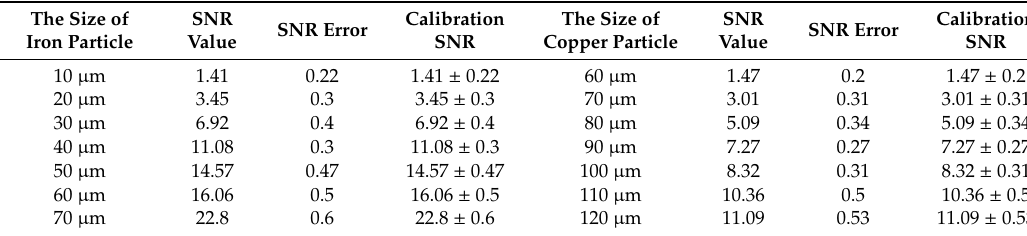
Table 1. Calibration of SNR of different particles.